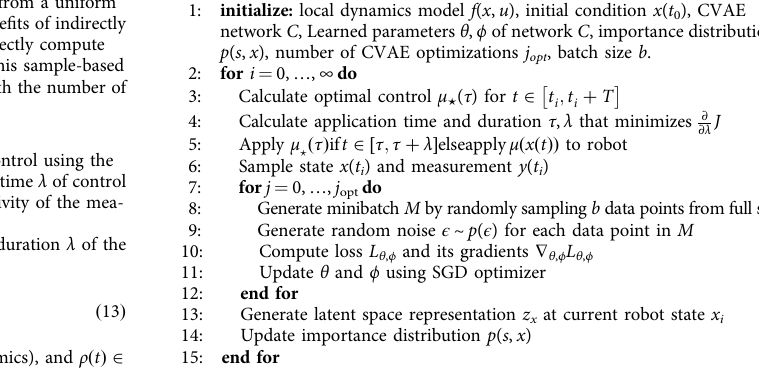
Algorithm overview . We provide an outline of our KL-E 2 method in Algorithm 1 for real-time active learning for sensor model estimation. Algorithm 1 . KL-Ergodic exploration (KL-E 2 ) for variational